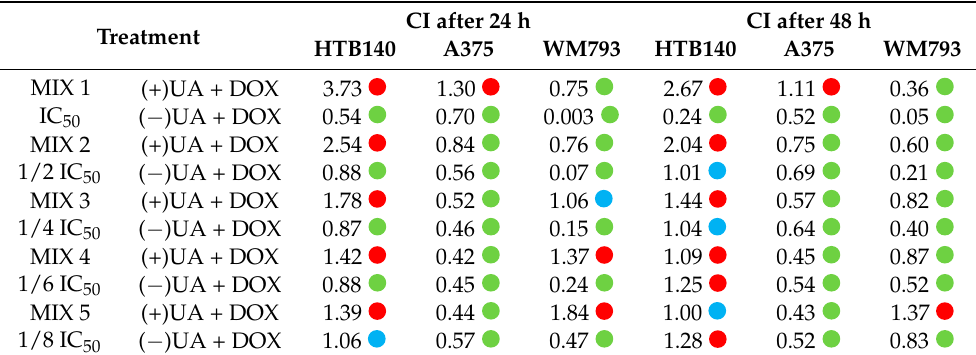
Table 2. Isobolographic analysis of the combinations of (+)- or ( − )-usnic acid (UA) with doxorubicin (DOX), performed as combination index (CI). Mixes were prepared at fixed ratio (1:1), based on the following fractions: 1 (MIX 1), 1/2 (MIX 2), 1/4 (MIX 3), 1/6 (MIX 4), 1/8 (MIX 5) of the respective IC 50 values; CI < 1 synergism ( ); CI = 1 ad- ditive ( ); CI > 1 antagonism ( ).